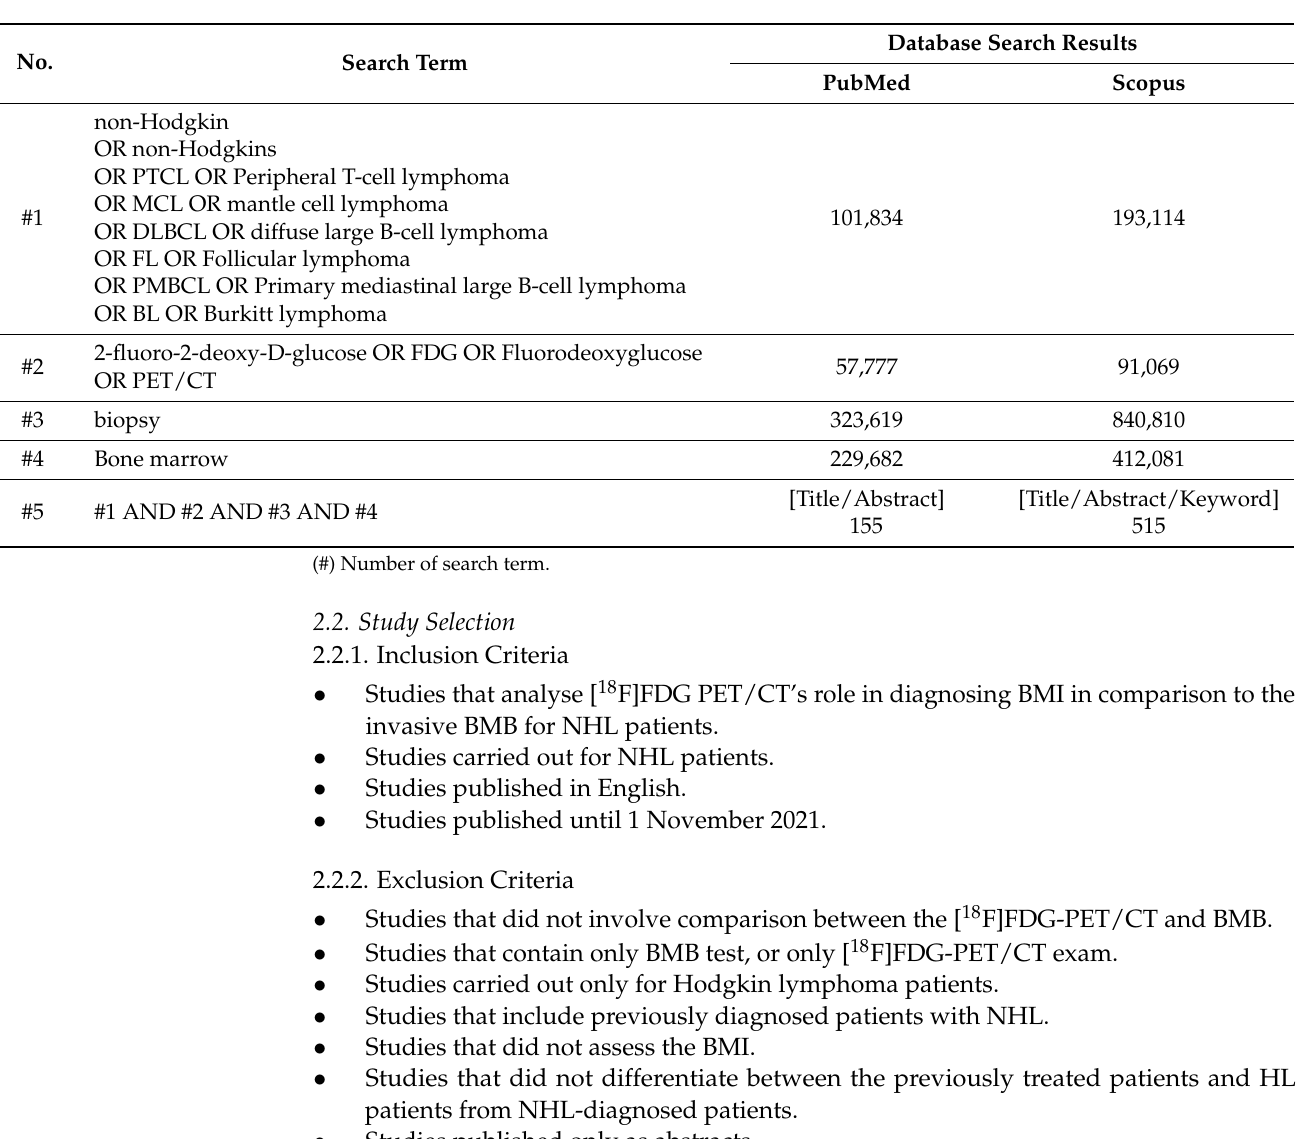
Table 1. Search strategy and results as on 1 November